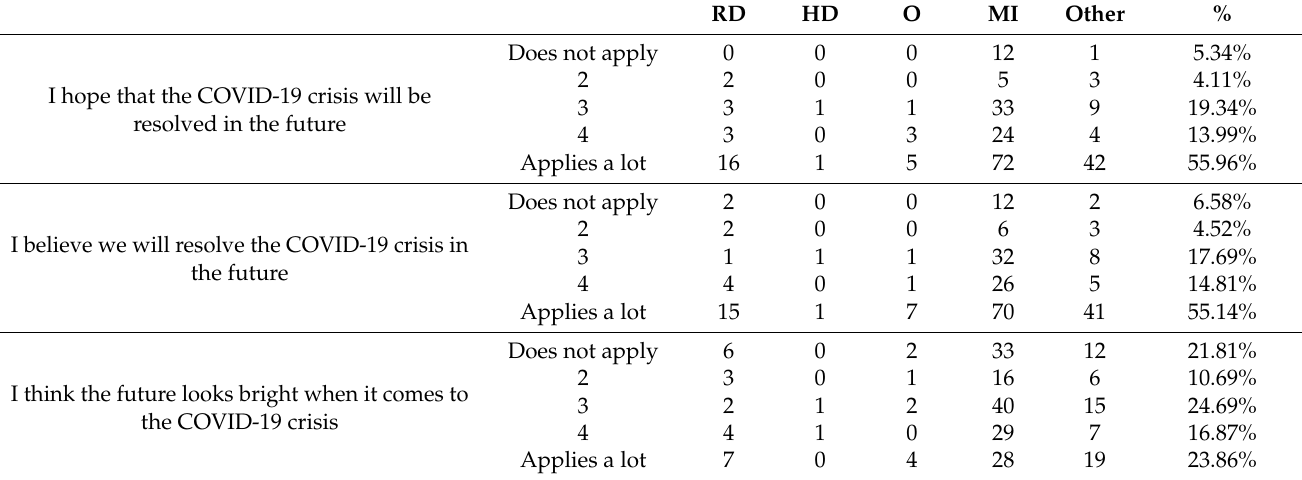
Table 10. Item number 3 (questions 1 to 3) of the EWB factor.